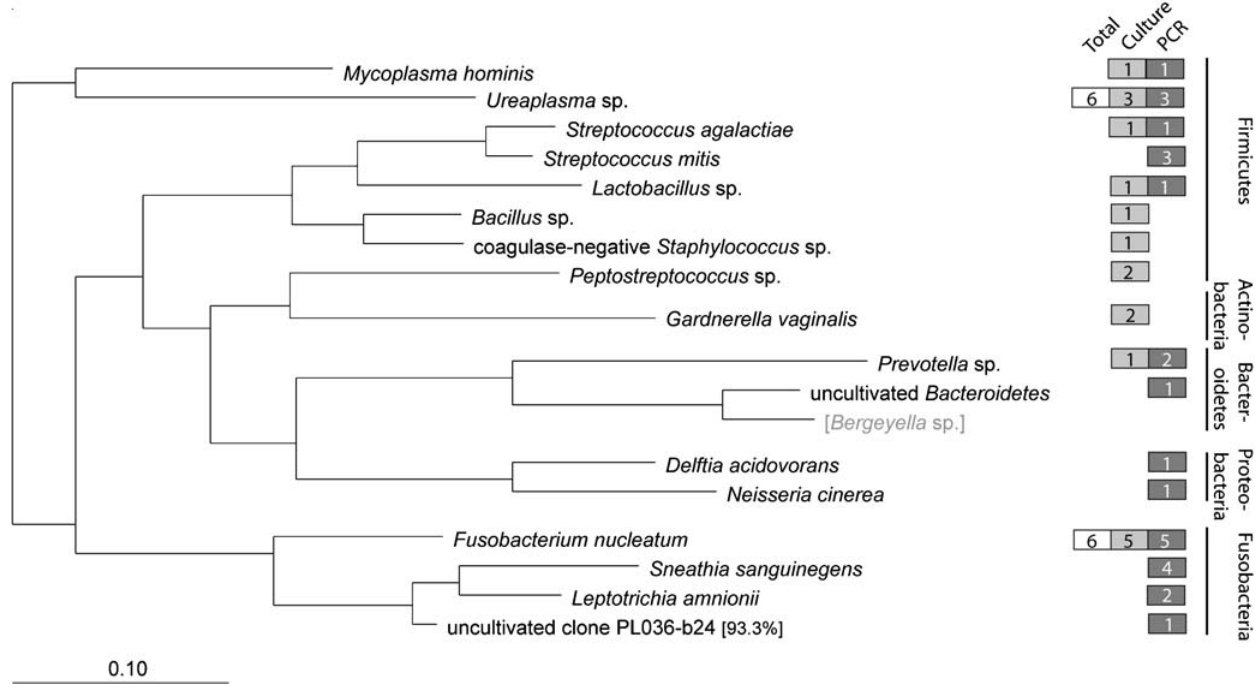
Figure 2. Microbial Diversity. Phylogeny of the 17 bacterial taxa identified in this study, based on a maximum likelihood algorithm. Colored boxes indicate the number of subjects who were positive for a given taxon by culture (gray) or PCR (blue) (some samples were polymicrobial). For most individual taxa, the larger of the two numbers in the corresponding gray or blue box represents the total number of positive subjects; for taxa where neither method detected all positive subjects, the total number is shown in the white box. A 99% sequence similarity cutoff threshold was used for phylotype assignment, which was based on 621 unambiguous nucleotide positions. Bergeyella sp. (bracketed and in gray type) is included as a reference species only and was not detected in the study population. A single fungal species, Candida albicans , was detected by culture in 1 subject and by PCR in 2 (data not shown). GenBank accession numbers of bacterial and fungal rDNA sequences from this study appear in Supporting Table S2.